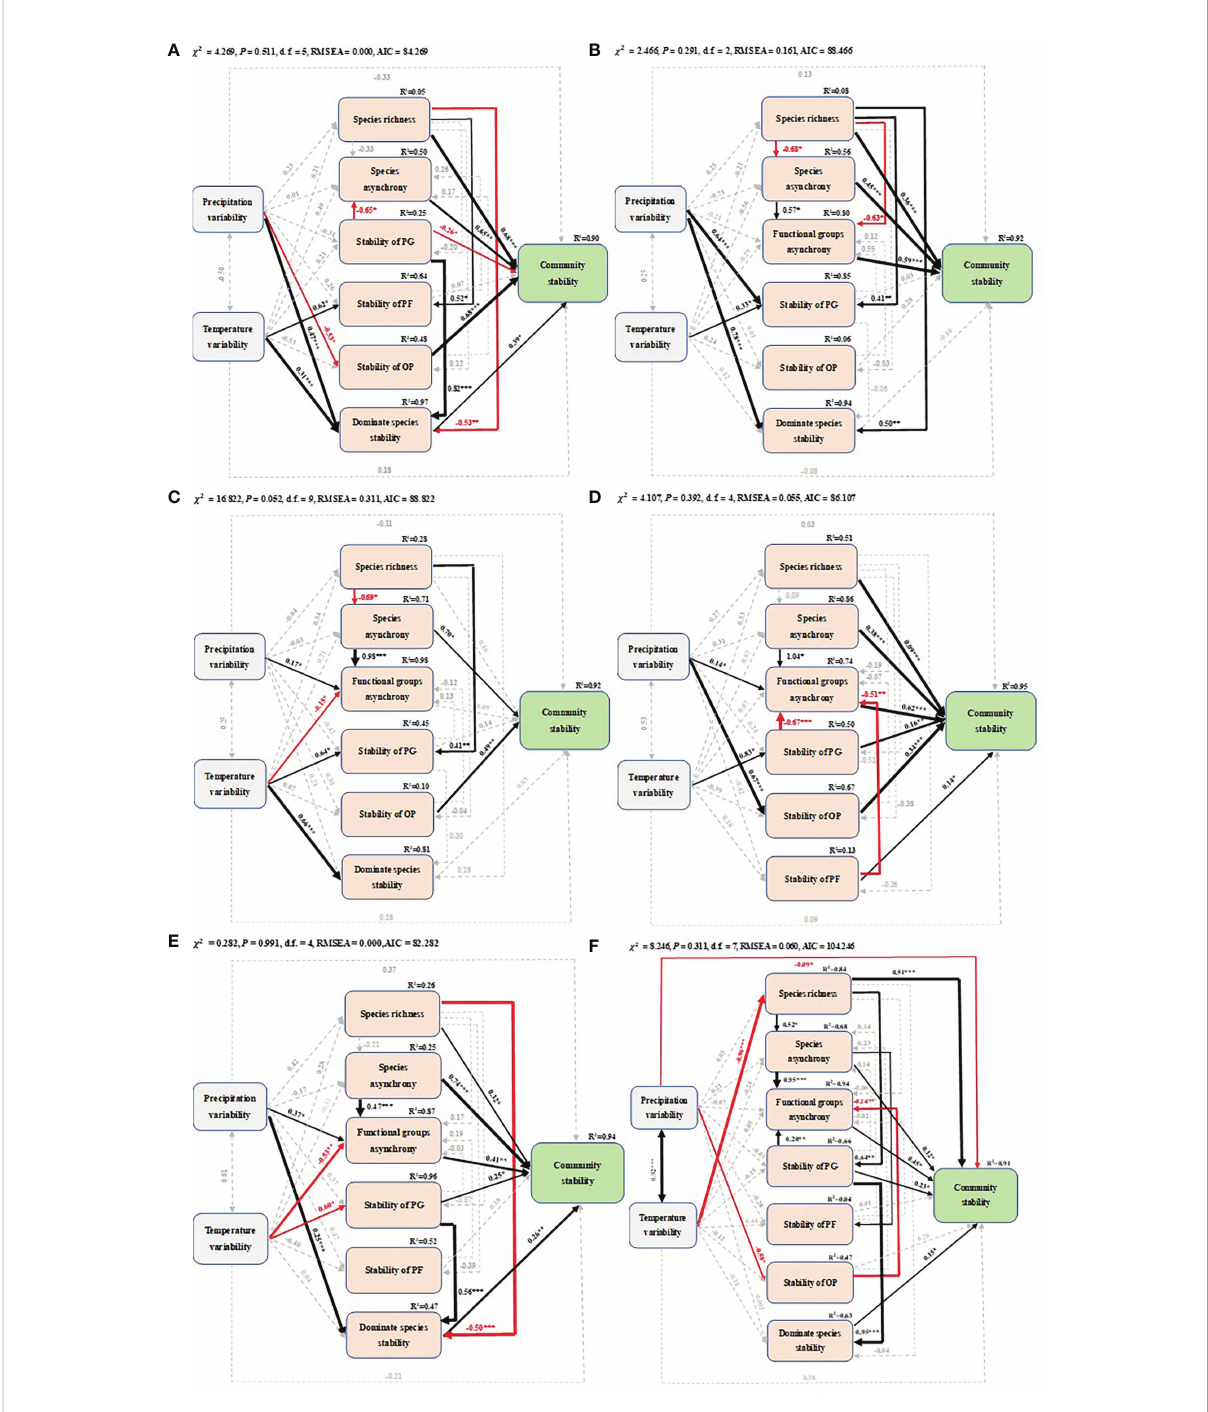
FIGURE 5 Structural equation models of precipitation (temperature) variability, species richness, species asynchrony, functional group asynchrony, temporal stability of PG (perennial grass), temporal stability of PF (perennial forbs), temporal stability of OP (other plants) and dominant species temporal stability on community temporal stability in different months of the growing season: (A) May, (B) June, (C) July, (D) August, (E) September and (F) the whole growing season. Black and red arrows represent signi fi cant positive and negative pathways, respectively, and grey dashed arrows indicate nonsigni fi cant pathways. Arrow width is proportional to the strength of the relationship. Numbers adjacent to arrows are standardized path coef fi cients and indicate the effect size of the relationship. The proportion of variance explained (R 2 ) appears alongside response variables in the model, and asterisks indicate statistical signi fi cance (*P< 0.05, **P< 0.01, ***P<